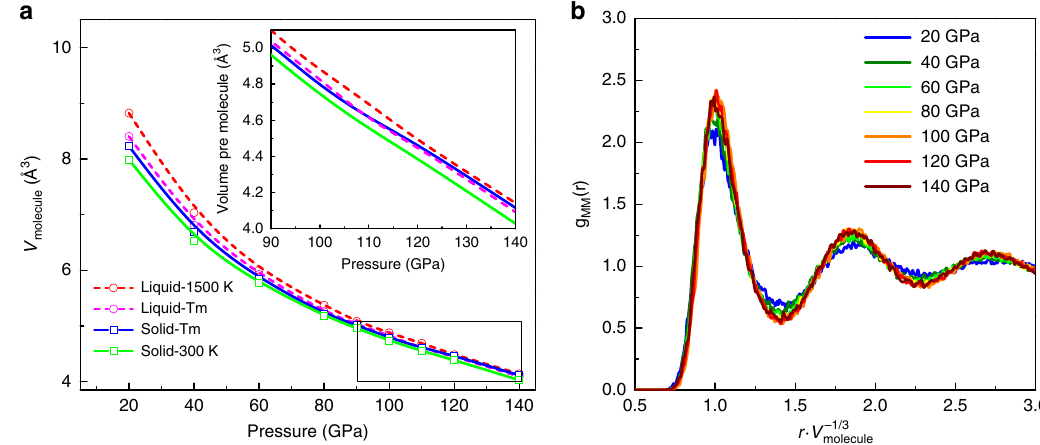
Fig. 3 Structural properties and EOS of liquid H 2 at different densities. a Equation of state (EOS) for liquid and solid H 2 at selected temperatures. The green and blue solid line is the EOS of Phase I at 300 K and T m (melting point), respectively. The pink and red dash line is the EOS of liquid at T m and 1500 K, respectively. b Normalised radial distribution function of molecular centres at selected pressures and T = 1000 K, indicating no liquid – liquid phase transition below 140 We hypothesised that molecules can get closer together if Figure 5b investigates this further using DFT, showing that the their constituent atoms are further apart (i.e. in an “ X ” T con fi guration which optimises the quadrupole interaction shape viewed down the intermolecular vector). By contrast, becomes unfavourable with respect to the X con fi guration at a the solid has orientations which offer higher cohesive separation of 2.25 Å . As we saw in Fig. 4, the nearest neighbours energy. are already this close by 20 GPa.